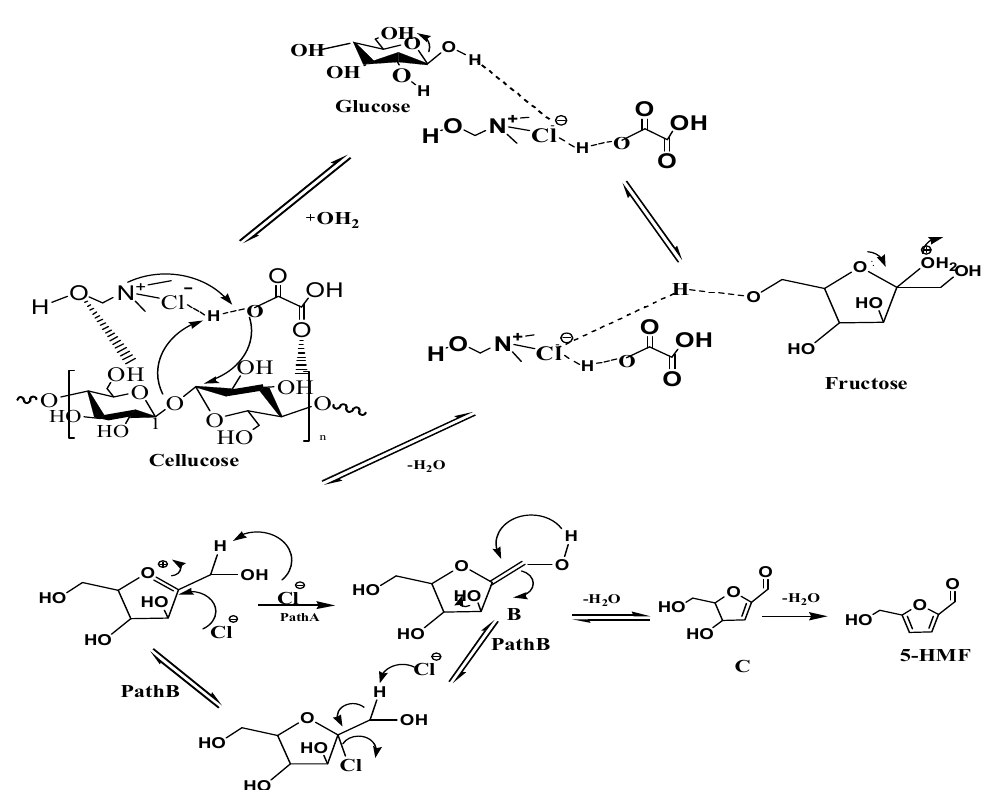
Figure 5. Mechanism of the conversion of cellulose to 5-HMF in a DES system.